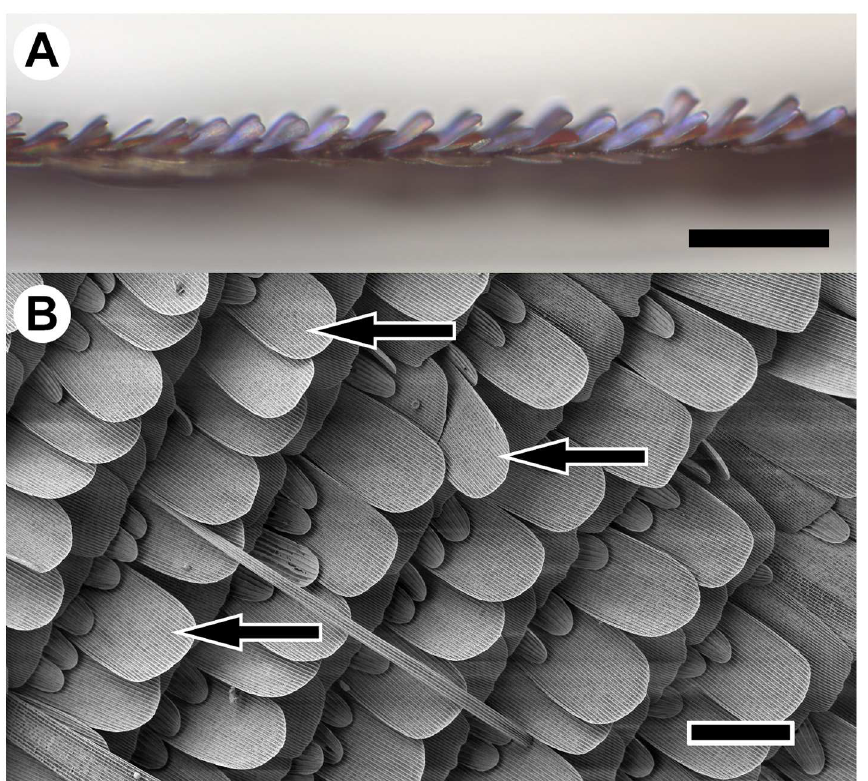
Fig 10. Arrangement of the scales on the dorsal wing surface. (A) Optical microscopeimage of a Polyommatus icarus wing section showingthe angle of the scales to the wing membrane. Scale bar: 250 μ m. (B) SEM image showingthe complex arrangementof different scale types: a few degreesof rotation around the cover scale axis can be observed(some examplesare indicatedby arrows). Scale bar: 100 μ m. Both factors contribute to the variabilityof the structural colorationand to the larger deviationof the perpendicular